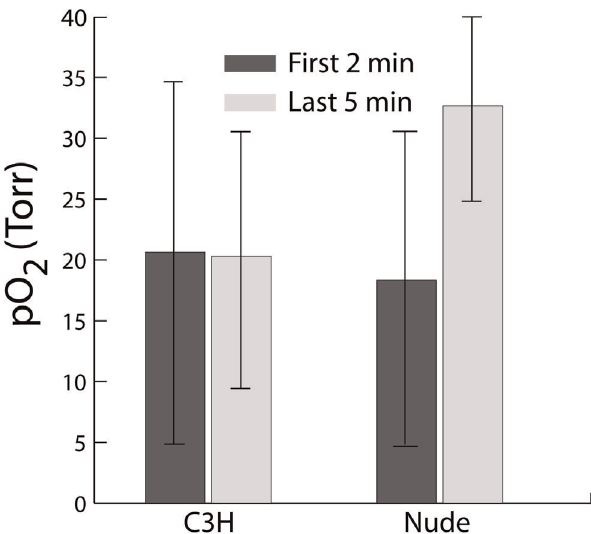
Figure 4. Tumor oxygenation is not significantly different between the two strains. Tumor oxygenation (mean 6 SD) in animals of each strain for measurements made at the beginning and the end of a one-hour period. Oxygen concentrations measured by phosphorescence lifetime monitoring. (N=6 for each strain.)